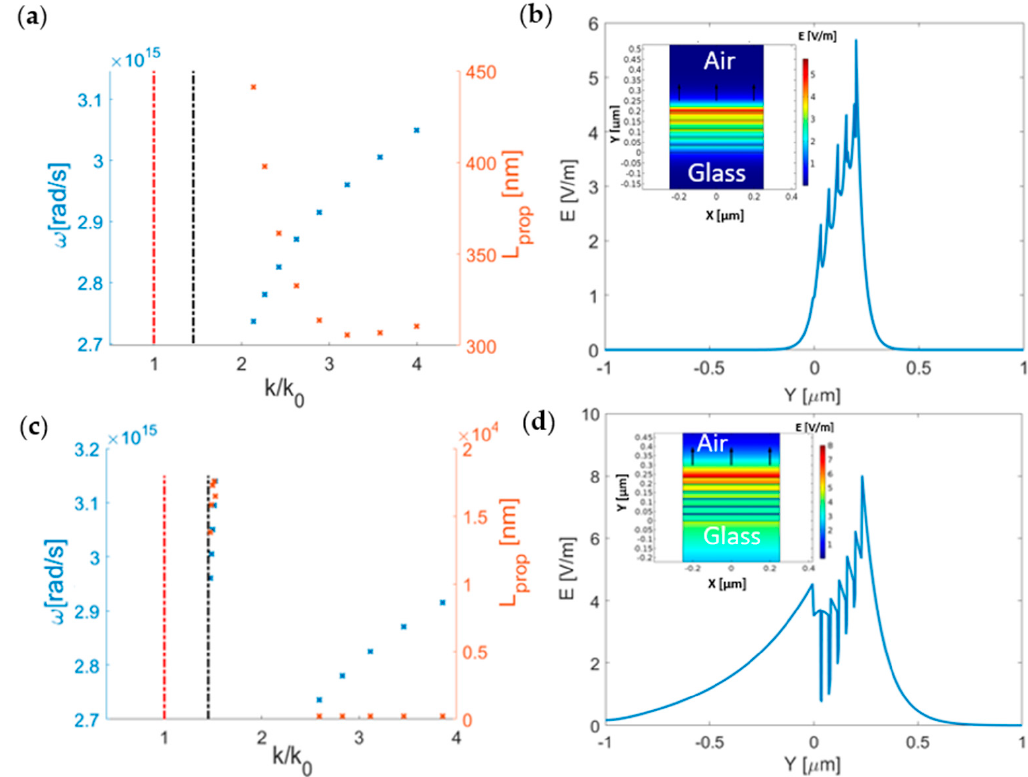
Figure 3. ( a , c ) Dispersion relation (blue) and propagation length (red) of the propagating modes found with the modal analysis for the Au and Al 2 O x top layer configurations, respectively. The black and bright red dash − dotted lines show the light lines in glass and air, respectively. ( b , d ) Electric field profile at 637 nm ( ω = 2.96 × 10 15 rad/s) extracted along the Y direction in the center of the MM with the Au and Al 2 O x top layers for the propagating modes. In the inset, the corresponding surface plots of the E field are shown. The black arrow (electric field orientation) shows that the modes are TM − polarized.